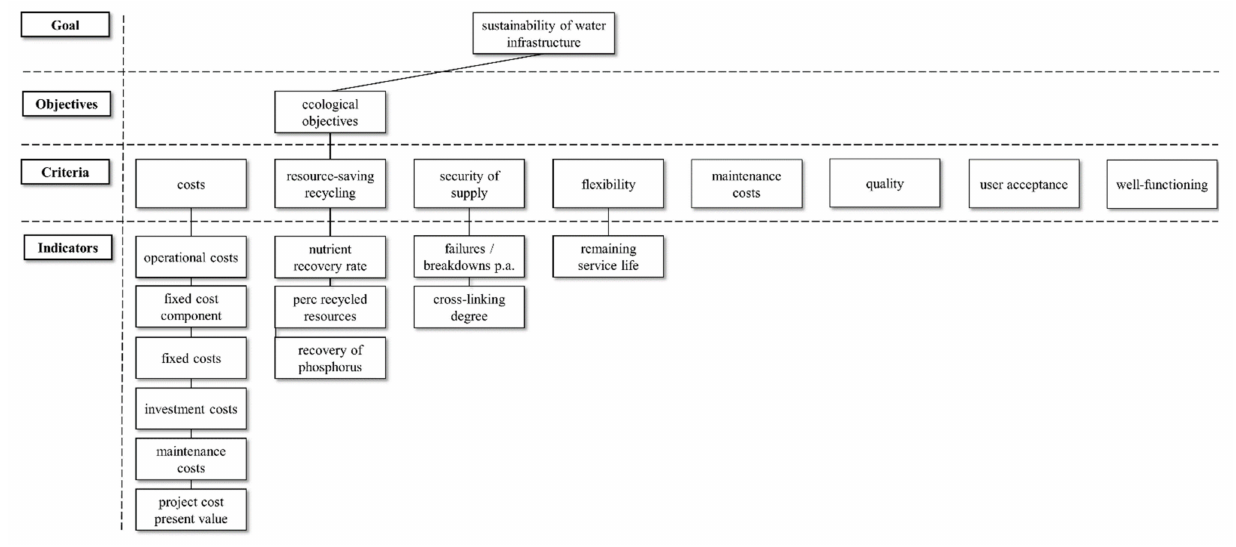
Figure 8. Validation study result: preliminary set of objectives